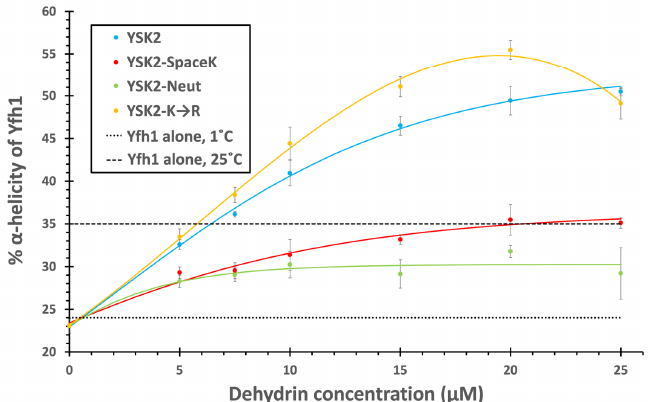
Figure 6. The Relationship between Yfh1 helicity and construct concentration. The CD spectrum of 10 μM Yfh1 was determined at 1 °C in 10 mM Tris, pH 7.4, in the presence and absence of the various dehydrin constructs. The equation described in Section 2 was used to find the percent α -helicity of Yfh1. Three replicates were used to create this image and the standard deviation is represented by the error bars. The dashed line indicates the helicity of Yfh1 alone at 25 °C, while the dotted line indicates the helicity of Yfh1 alone at 1 °C. YSK 2 , light blue line; YSK 2 -SpaceK, red line; YSK 2 -Neutral, green line; YSK 2 -K → R, yellow line.